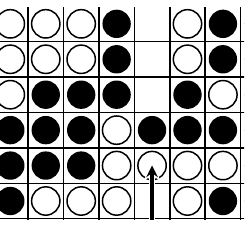
Figure 69. WHITE